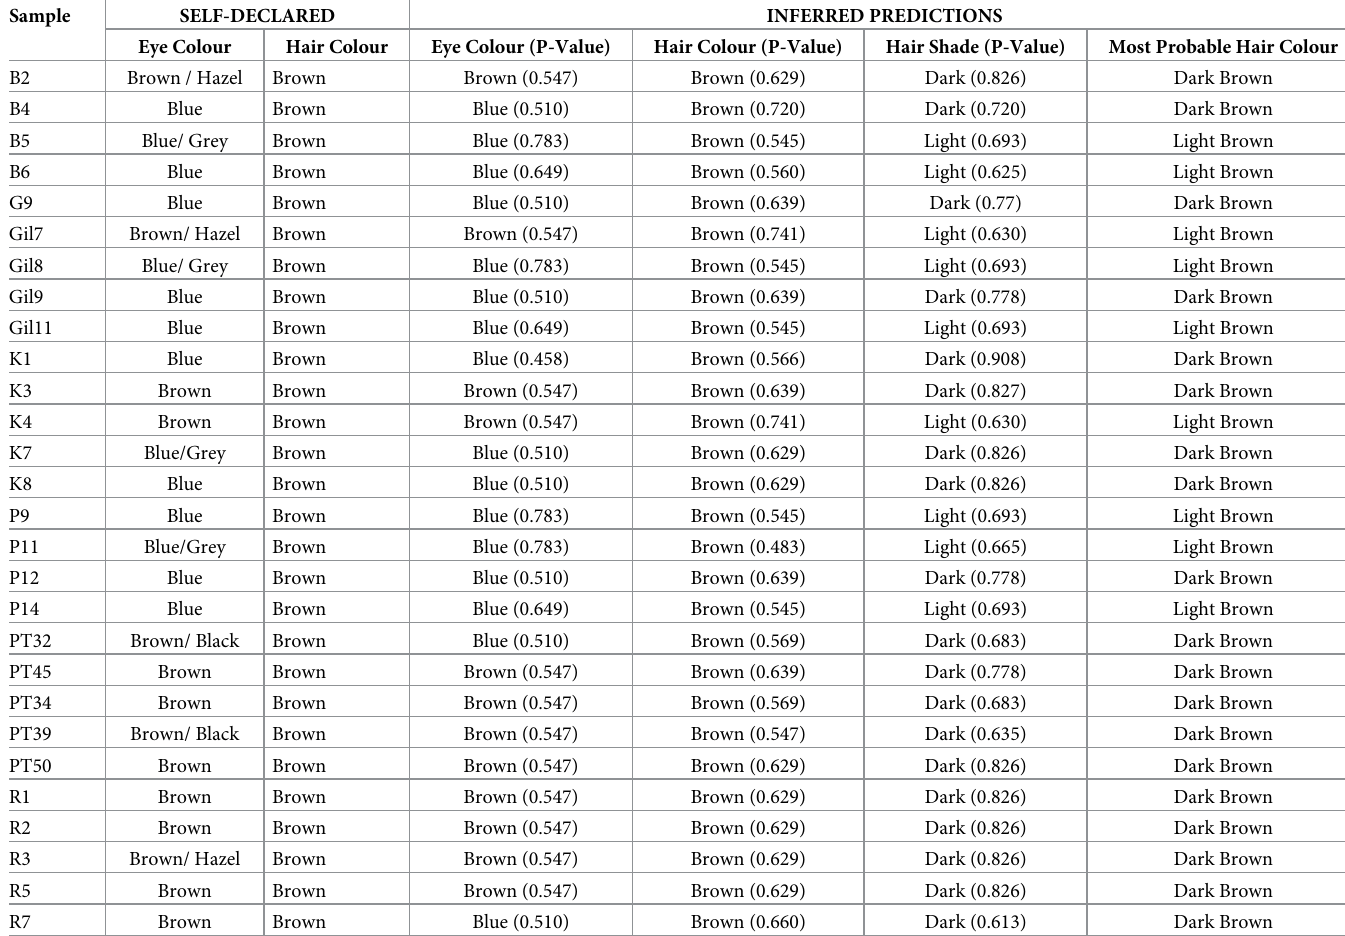
Table 5. Inferred eye colour and most probable hair colour associated probabilities in terms of P-value for twenty-eight samples with known hair and eye colour using the HIrisplex SNPs in the custom enrichment